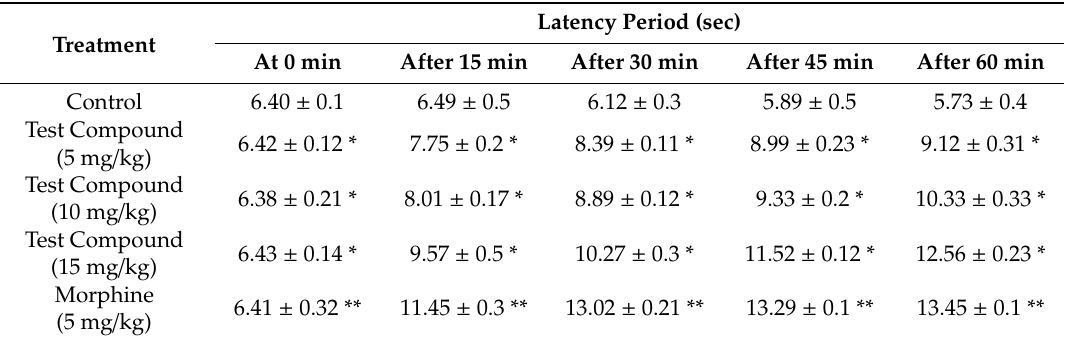
Table 2. Antinociceptive activity of quercetin-3-methoxy-4 (cid:48) -glucosyl-7-glucoside analyzed by hot plate method in mice.